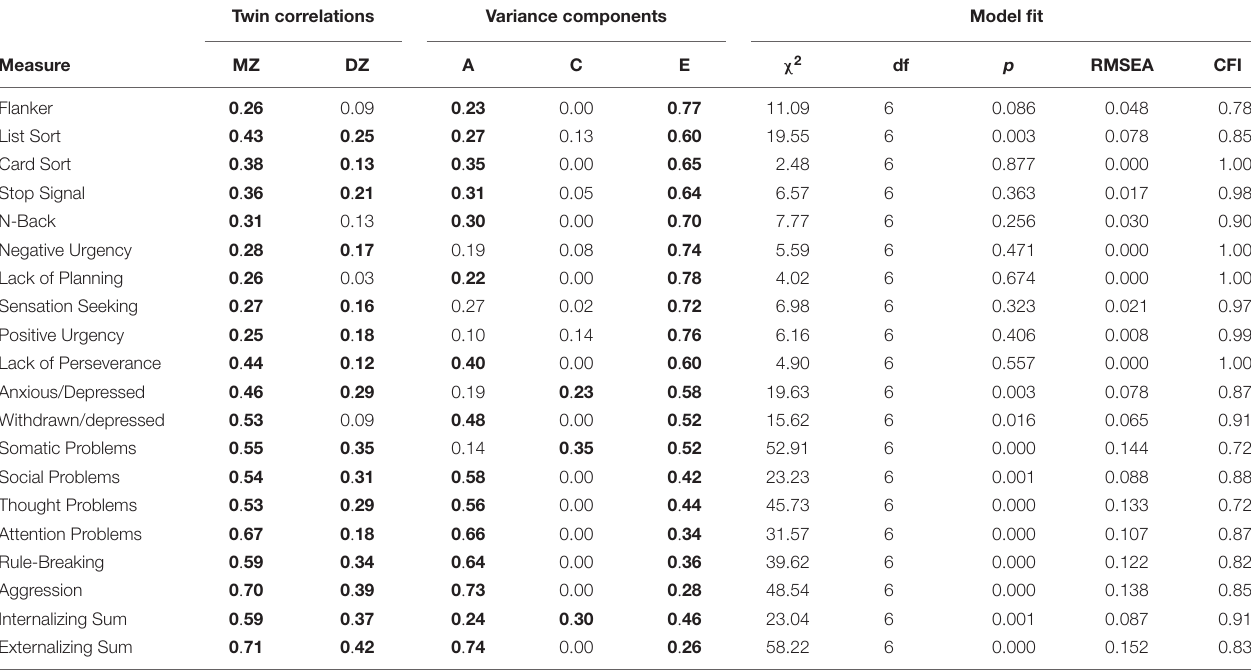
TABLE 3 | Twin correlations, variance components, and model fit indices for univariate ACE models of cognitive tasks and survey measures. Twin correlations Variance components Model fit